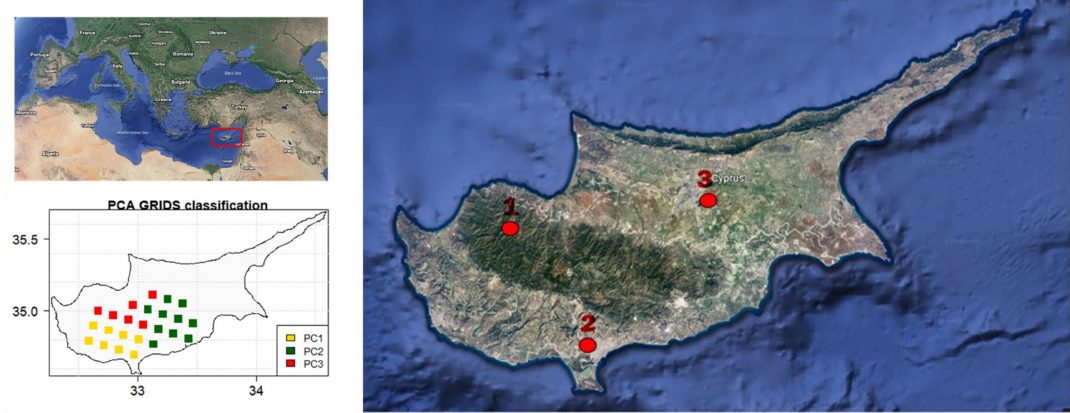
Figure 1. Location and topography of the Cyprus area (image provided by Google Earth: https: // earth.google.com / web / ). Map of area’s classification according to Principal Component Analysis PCA (bottom-left map). Red points—three points with di ff erent characteristics; one form each